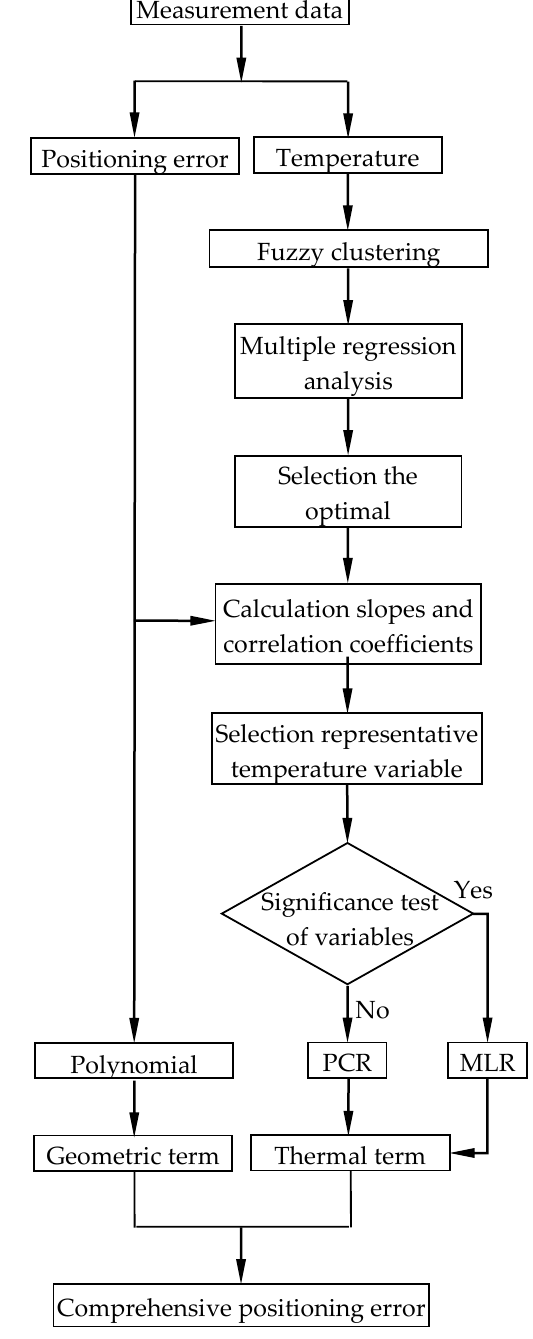
Figure 2. The flow chart of the thermal positioning error modeling.